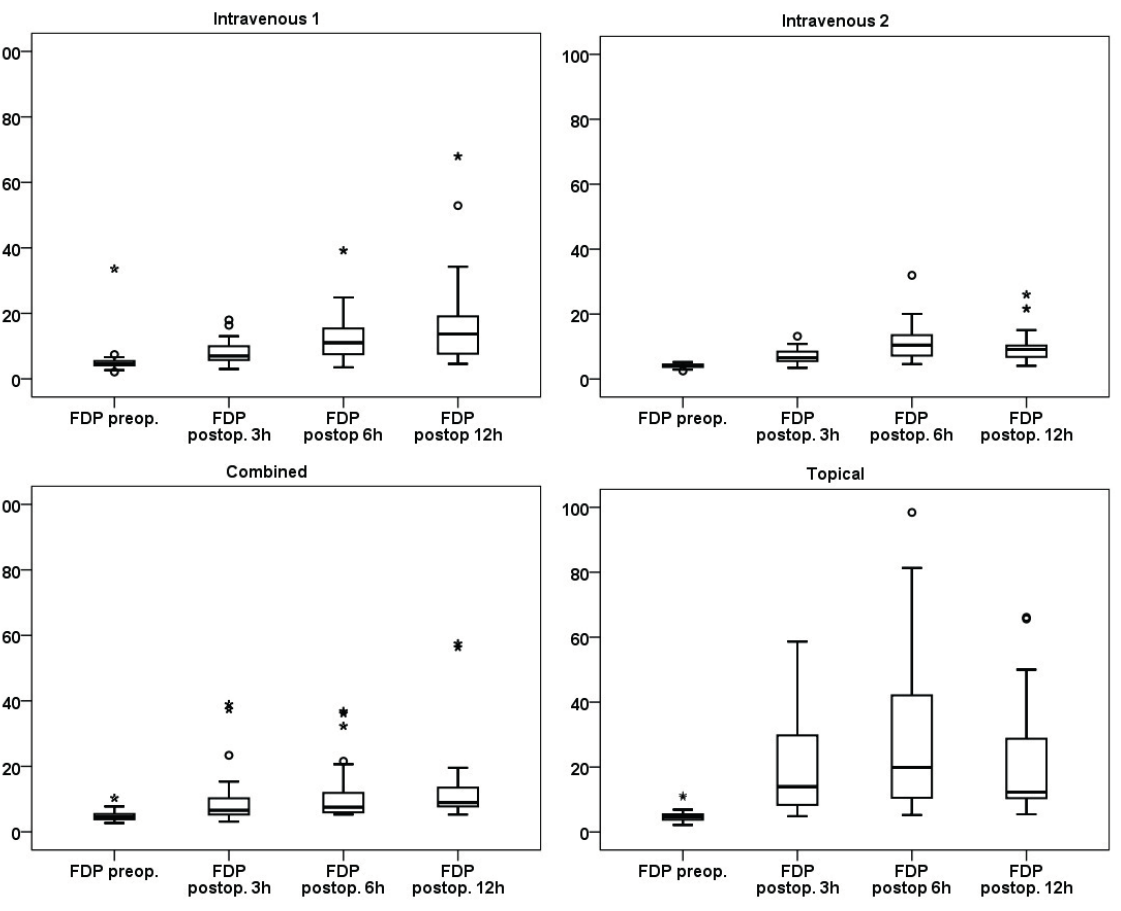
Fig. 2. Comparison of FDP for each group after 3, 6 and 12 h after the start of the